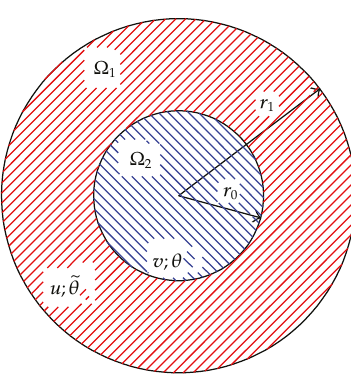
Figure 1: Domains Ω 1 and Ω 2 and boundaries of the transmission